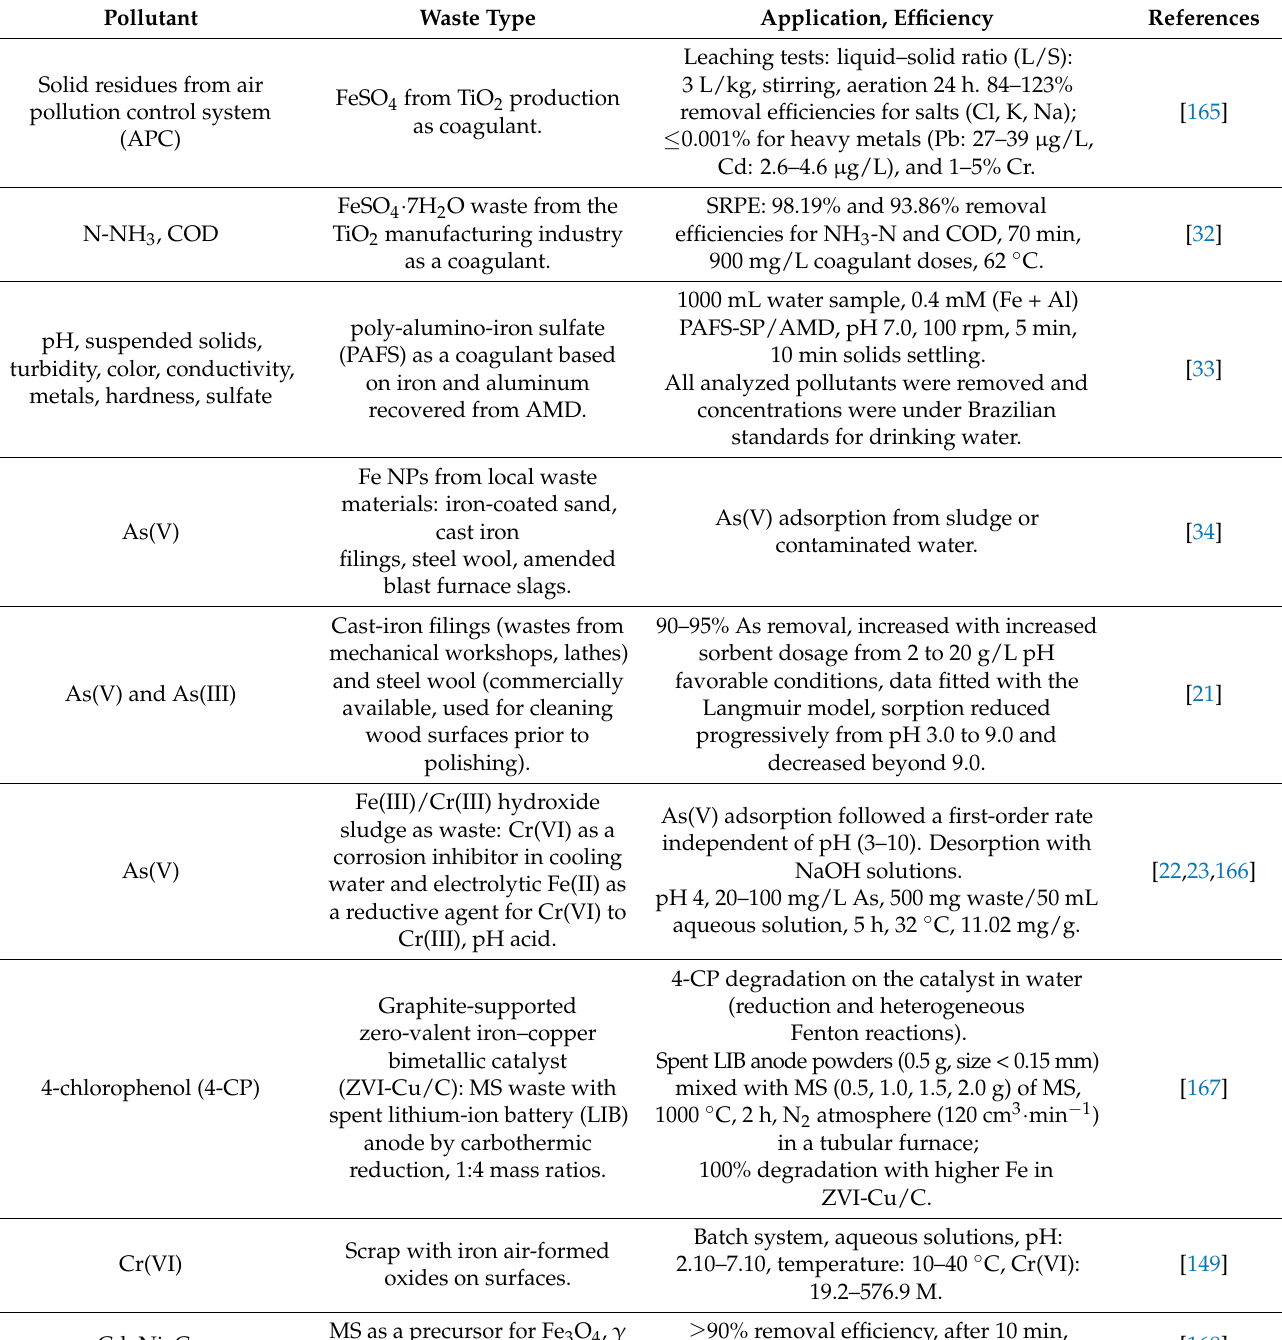
Table 2. Efficiencies regarding pollutant removal applying valorized ferrous